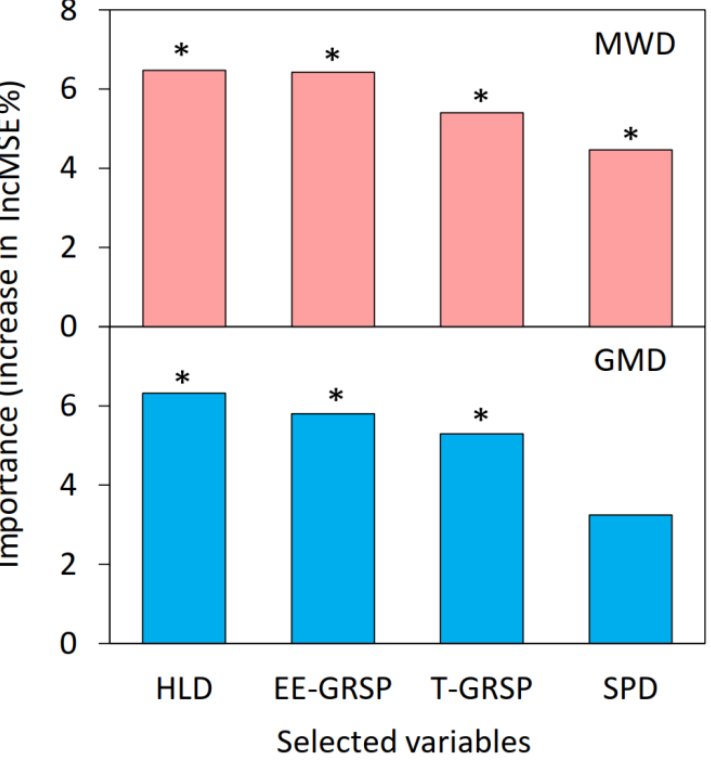
Figure 7. Random forest variable importance plot. The variables are ranked in order of relevance in predicting soil aggregate stability (MWD and GMD). The importance measure considered for the analysis is the mean decrease in accuracy computed via random forest classification algorithm. HLD, hyphal length density; SPD, spore density; T-GRSP, total glomalin-related soil protein; EE-GRSP, easily extractable glomalin-related soil protein (* p <